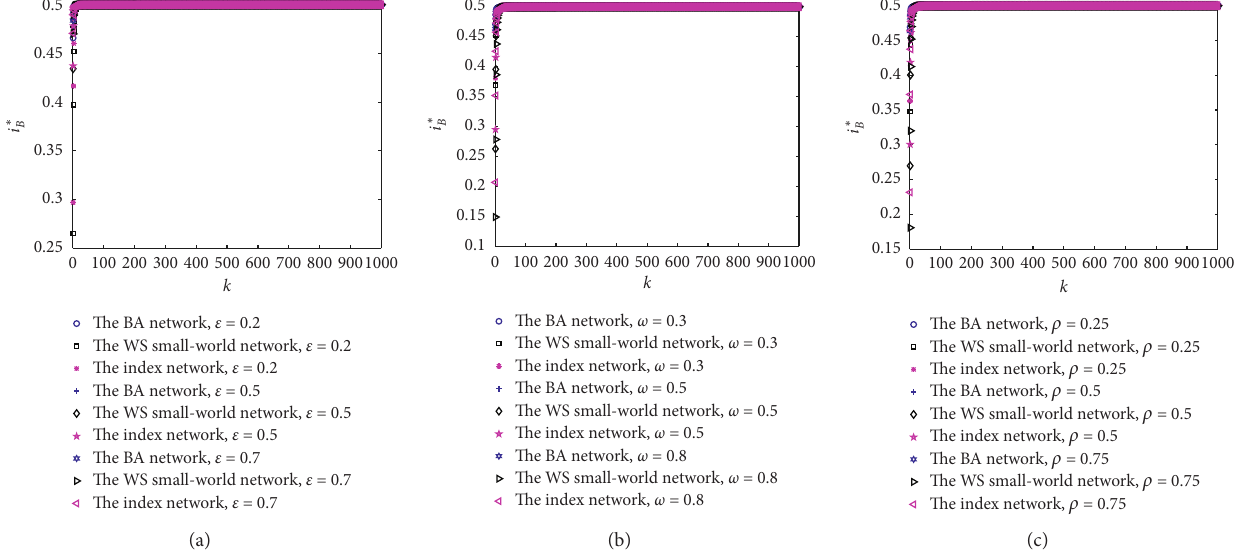
k of the corporate B . (a) The degree